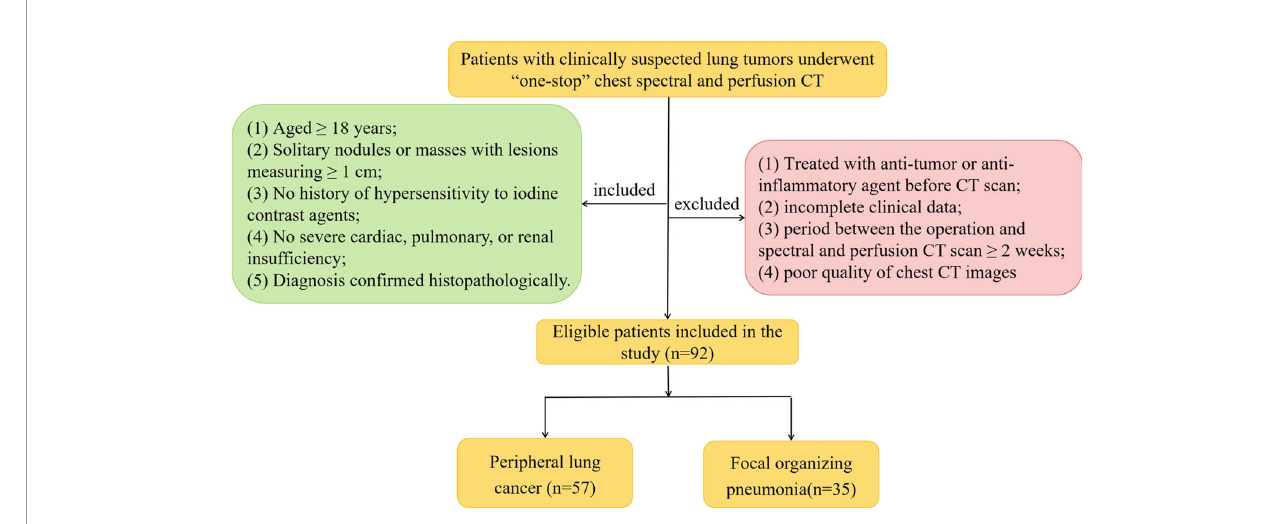
FIGURE 1 | Flowchart of inclusion and exclusion